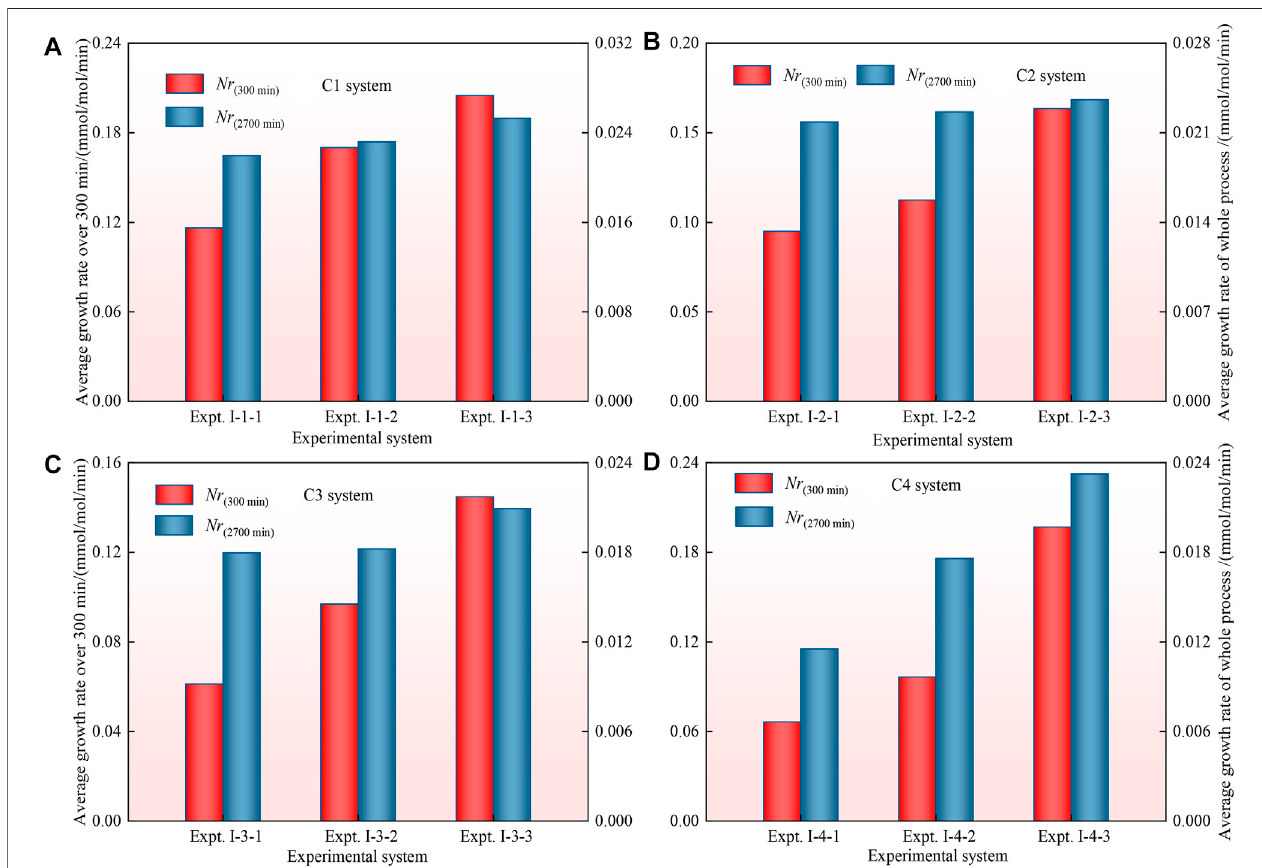
FIGURE 6 | Histogram comparing the average growth rate of CO 2 hydrates in the C1-C4 systems.